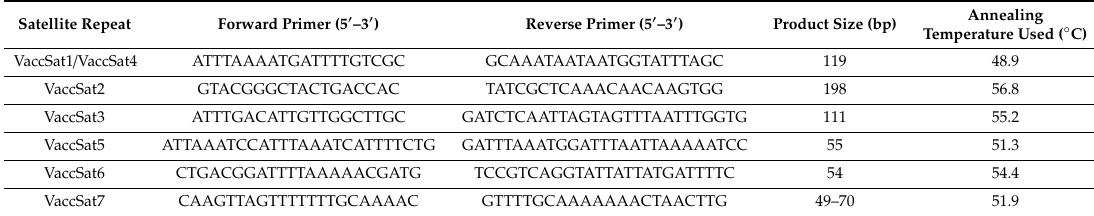
Table 2. Primer pairs for satellite